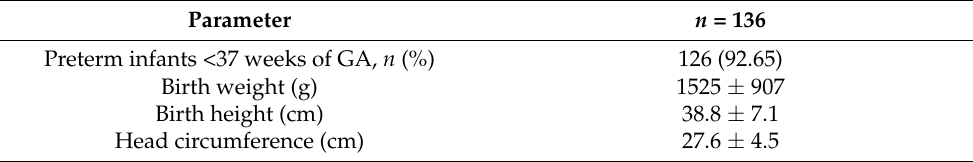
Table 1. Cont. Parameter n = 136